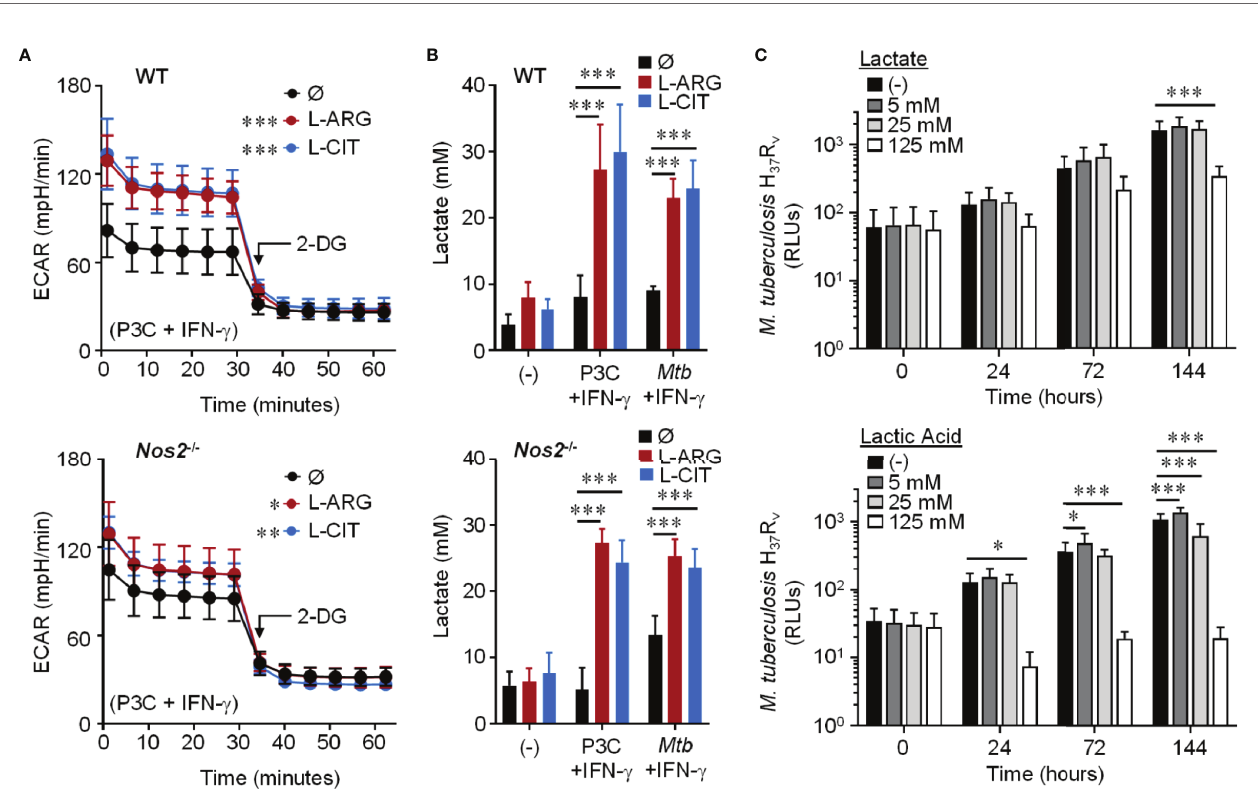
FIGURE 4 | Effect of L-arginine/L-citrulline on macrophage glycolysis and lactate production. (A) PM F s from C57Bl/6 (WT) or Nos2 -/- mice were stimulated with Pam3Cys (P3C) plus IFN- g in R-free C-DMEM containing 400 m M L-arginine, 400 m M L-citrulline, or neither amino acid for 24 hours. Following stimulation, cells were incubated in R-free Seahorse media containing 400 m M L-arginine (red), 400 m M L-citrulline (blue), or neither amino acid (black) for 1 hour prior to analysis via Seahorse XF technology. After 30 minutes, 2-DG (100 mM) was added to inhibit glycolysis. The extracellular acidi fi cation rate (ECAR) was determined over time (N ≥ 16, three experiments combined). (B) PM F s from C57Bl/6 (WT) or Nos2 -/- mice remained unstimulated (-) or were stimulated with P3C plus IFN- g or infected with Mtb